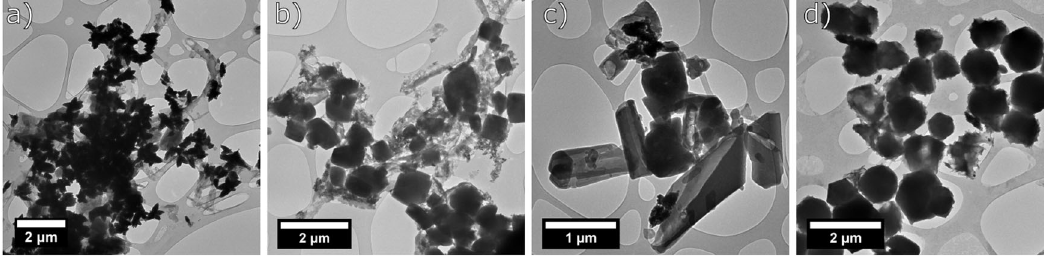
Fig. 8 TEM Images of washed materials. TEM images of samples washed at a 6 h, b 24 h, c 48 h, and d 72 h.